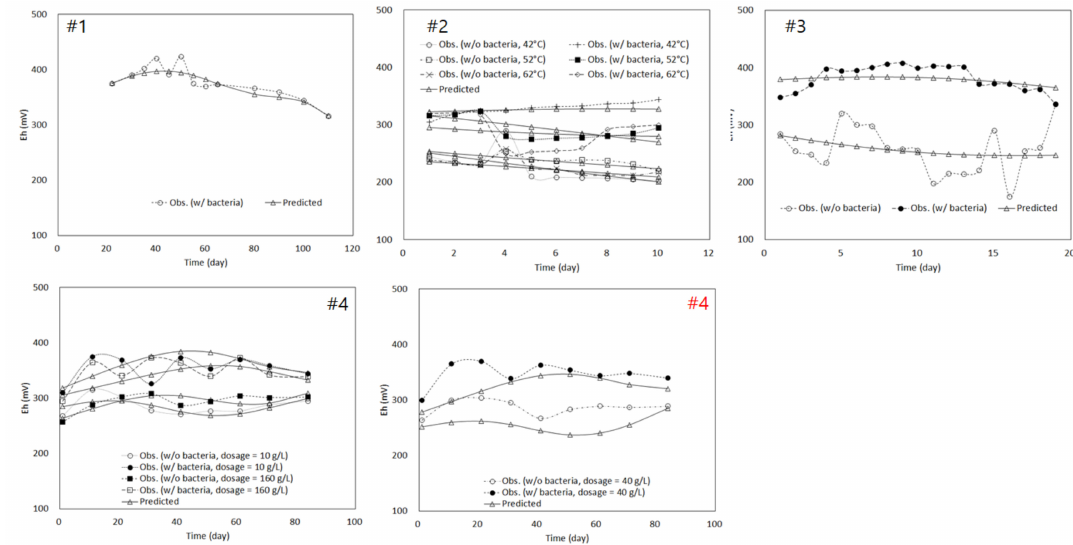
Figure 4. Observed and ANN-predicted Eh changes with a topology of 9:8:1. The numbers are from Table 1, while the red number is the result from the data for further